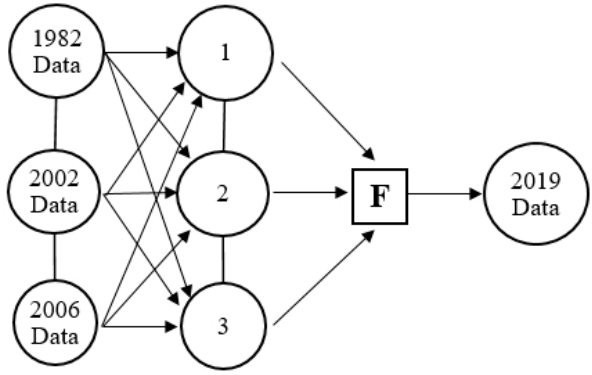
Figure 3. Architecture of the multilayer perceptron network.